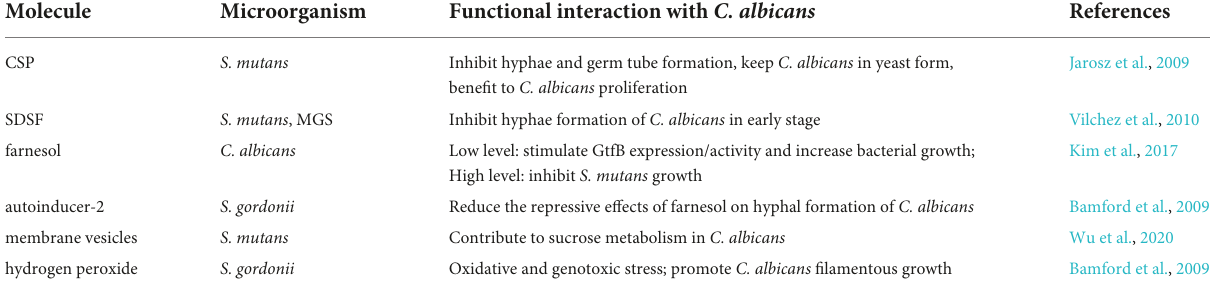
TABLE 1 Summary of extracellular signals modulating C. albicans interactions between oral bacteria.